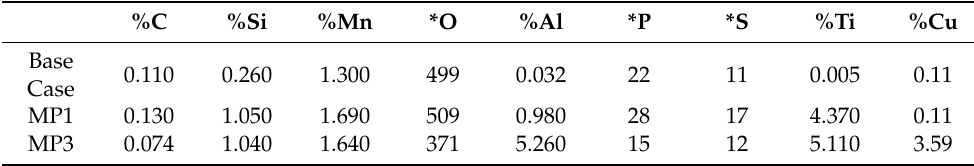
Table 3. Weld metal